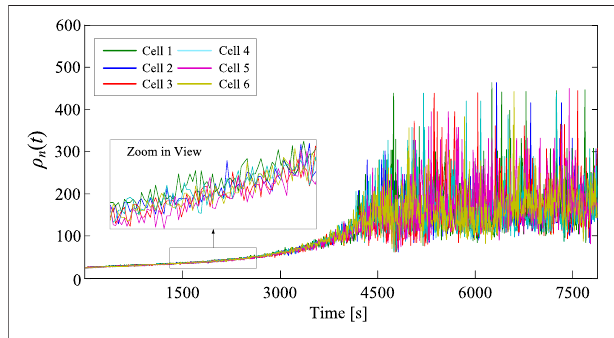
FIGURE 6 | Dynamic acceleration coef fi cient in the charging